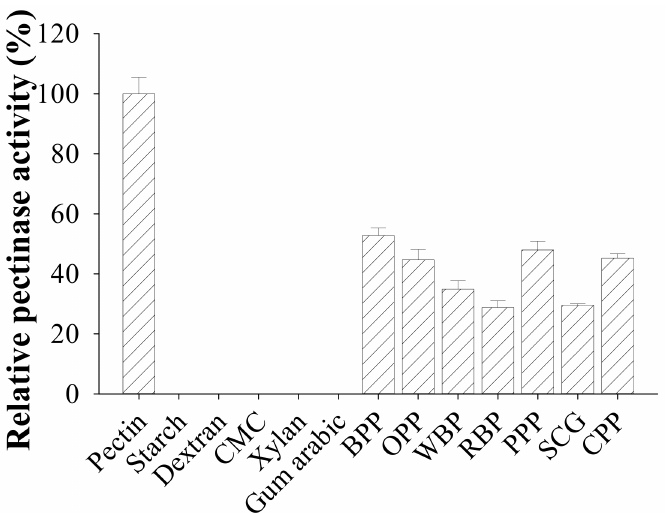
Figure 5. Substrate specificity of B. amyloliquefaciens TKU050 pectinase, including CMC (Car- boxymethyl Cellulose), BPP (banana peel powder), OPP (orange peel powder), WBP (wheat bran powder), RBP (rice bran powder), PPP (pomelo peel powder), SCG (spent coffee grounds), and CPP (coffee pulp powder). All error bars are the ± SD (standard deviation) of three different